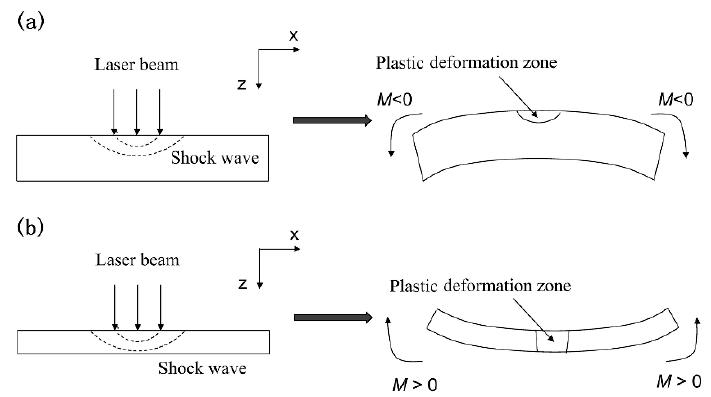
Figure 1. Bending mechanisms of laser peen forming: ( a ) SGM ( b ) SBM.